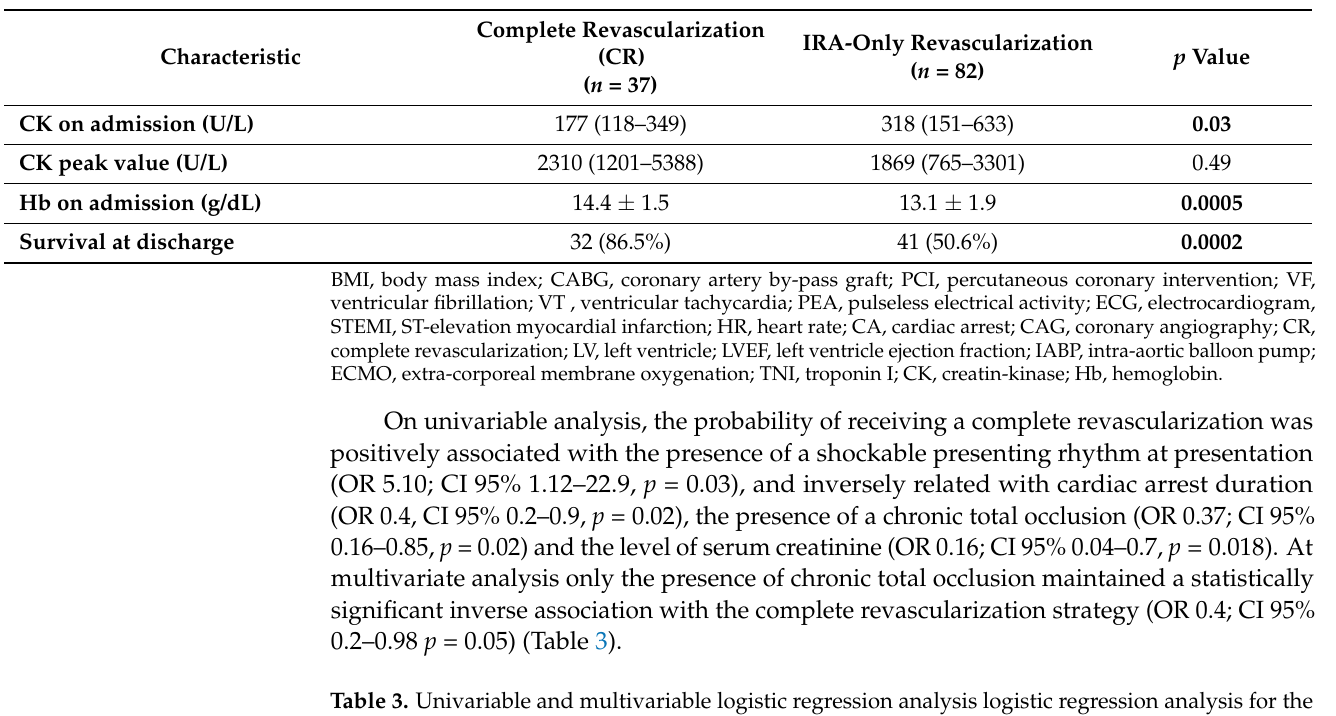
Table 3. Univariable and multivariable logistic regression analysis logistic regression analysis for the probability of receiving a complete